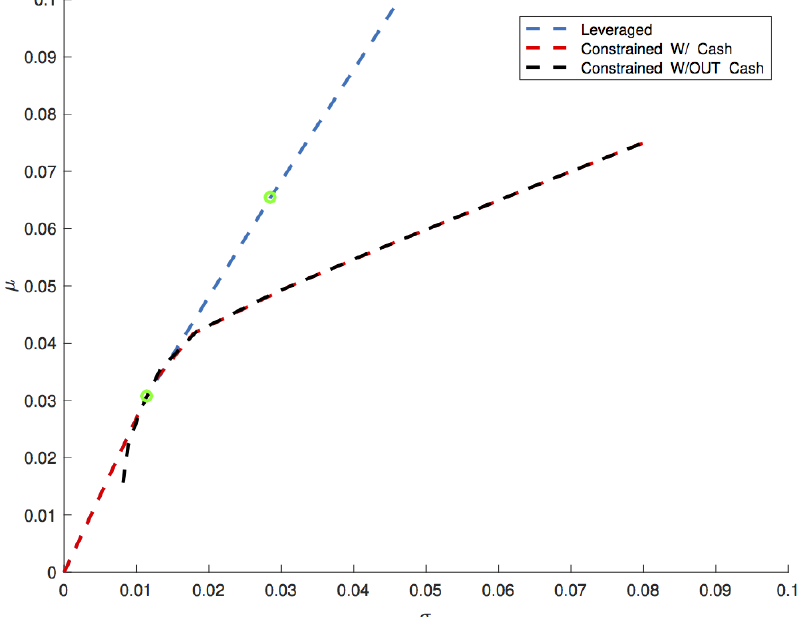
Figure 2. Comparison between leveraged portfolio with the classical Markowitz’s portfolios with the statistical hypotheses of Equations (41), (42) and